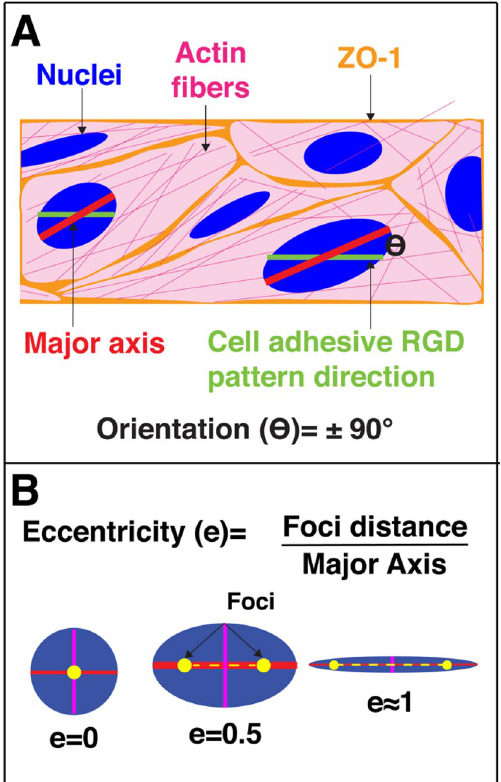
Figure 2. Schematic representing the data analysis. The nucleus, cell, or F-actin orientation with respect to the underlying peptide pattern and the nucleus or cell elongation was analyzed using Cell Profiler. ( A ) The cell, nuclei and F-actin were segmented from the images and fitted to an ellipse. The major and minor axis of the ellipse representation of the objects are identified. The orientation is determined by the angle between the major axis of the object and the underlying RGD pattern direction. ( B ) The nucleus or cell eccentricity indicates the elongation, where 1 is a line and 0 is a perfectly round circle.